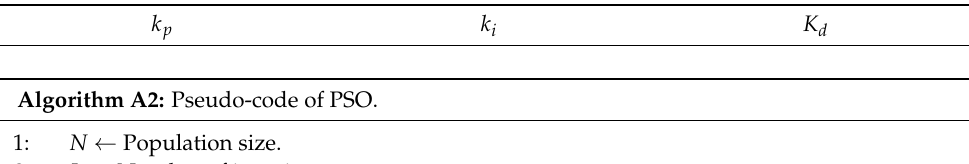
Table A1. PSO particle representation.